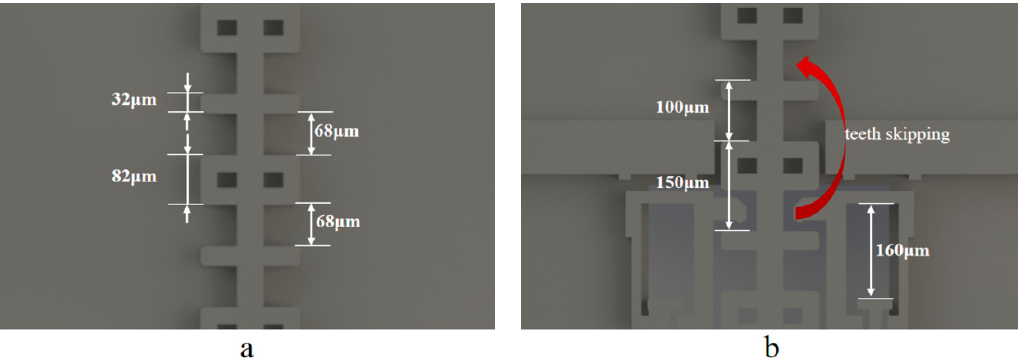
Figure 4. The illustration of the encryption system: ( a ) The slider with a unique sequence of teeth width; and, ( b ) The design for teeth skipping prevention.